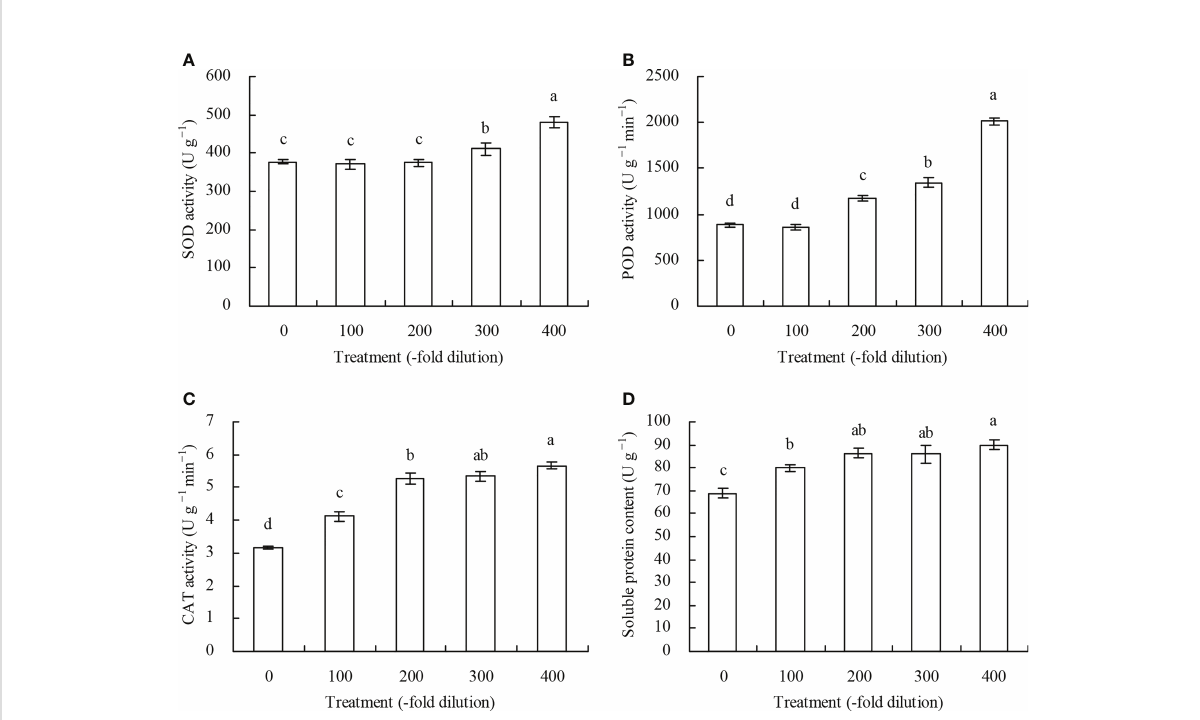
FIGURE 3 Antioxidant enzyme activity and soluble protein content of leaves of peach seedlings. (A) : SOD activity; (B) : POD activity; (C) : CAT activity; (D) : soluble protein content. Values are means ± SD of three replicates. Different lowercase letters indicate signi fi cant differences among the treatments (Duncan ’ s Multiple Range Test, P <